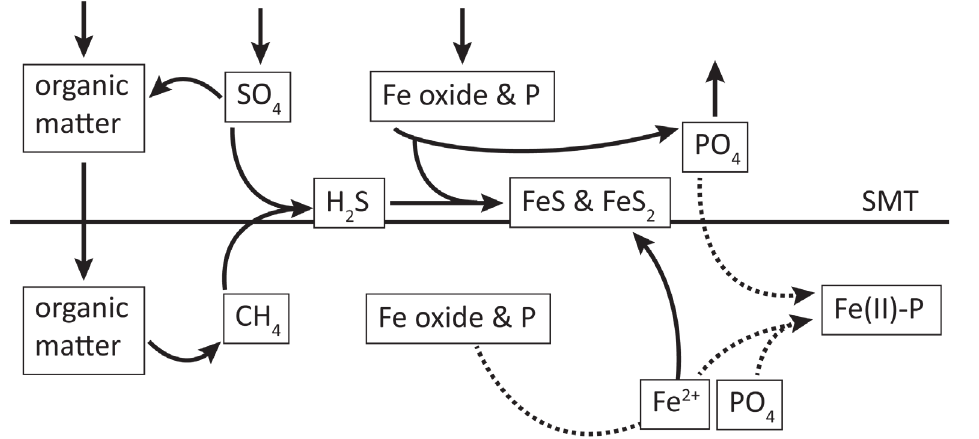
Figure 8. Schematic of key processes affecting S, Fe, CH 4 and P in and below the SMT. The dotted lines indicate how the release of Fe 2 + and PO 4 from Fe-oxides lead to Fe(II)-P formation.